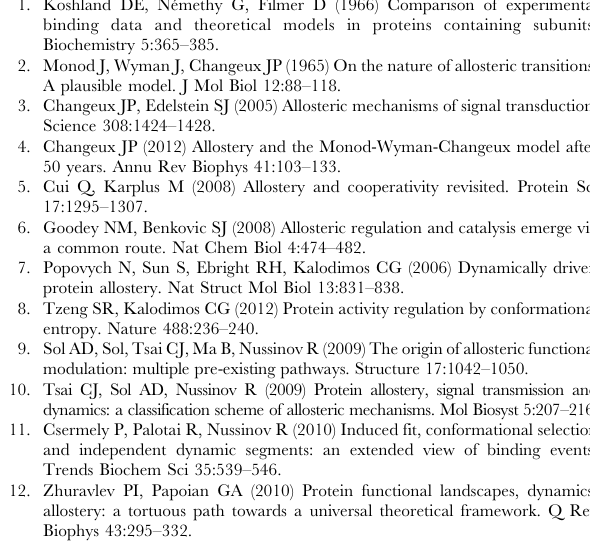
interaction communities are highlighted in spheres and colored according to their level of rigidity (flexibility) in the functional dynamics profiles. The communities are primarily aligned with the structurally rigid regions in the global dynamics profiles of the Hsp90 structures. (TIF) Figure S5 The Distribution and Composition of Residue Hubs in the HtpG Structures. The spatial distribution of local residue hubs are shown for the SAXS structure of apo-HtpG (A), and the crystal structure of apo-HtpG (B). The protein structures are shown in a ribbon representation and colored according to their domain nomenclature: NTD is in green, MD is in blue, and CTD is in red. The hub residues are shown in spheres and colored according to their respective domains. The amino acid composi- tion of highly connected hub nodes is shown for the SAXS structure in blue bars (C), and for the crystal structure of apo- HtpG structure in red bars (D). The residue hubs with the number of connected residues exceeding the threshold of four are shown. (TIF) Figure S6 The Distribution and Composition of Residue Hubs in the Nucleotide-Bound Chaperone Structures. The spatial distribution of local residue hubs is shown for the crystal structure of ADP-HtpG (A), ATP-Hsp90 (B), and ATP- Grp94 (C). The protein structures are shown in a ribbon representation and colored according to their domain nomencla- ture: NTD is in green, MD is in blue, and CTD is in red. The hub residues are shown in spheres and colored according to their respective domains. The amino acid composition of highly connected hub nodes is shown for the ADP-HtpG structure in green bars (D), for the ATP-Hsp90 structure in brown bars (E), and for the ATP-Grp94 in orange bars (F). The residue hubs with the number of connected residues exceeding the threshold of four are shown.